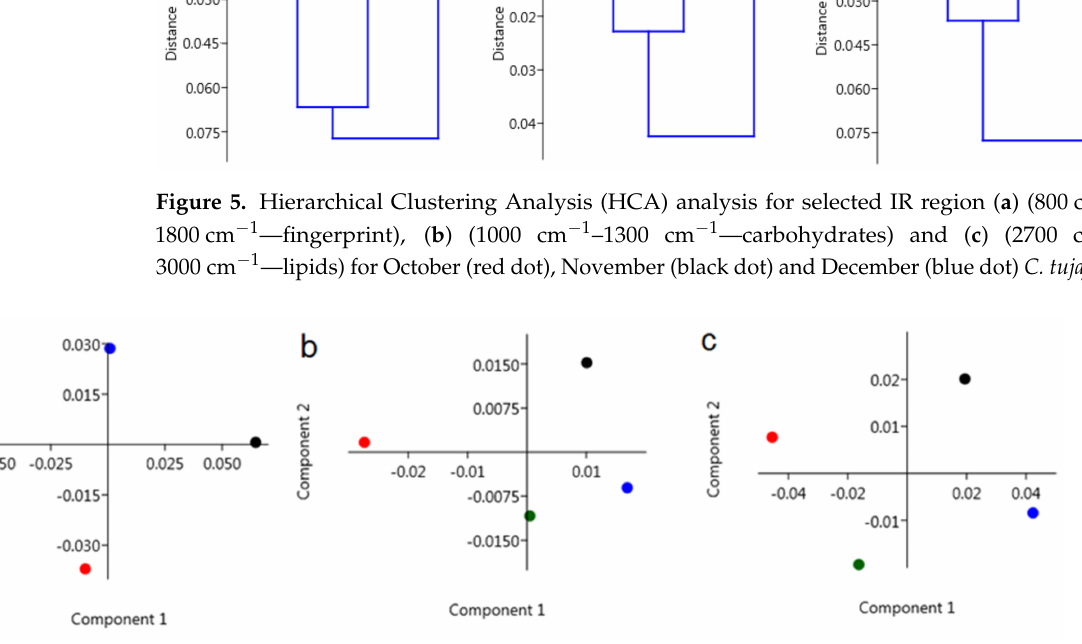
Figure 6. Principal Component Analysis (PCA) analysis for selected IR region ( a ) (800 cm − 1 –1800 cm − 1 —fingerprint), ( b ) (1000 cm − 1 –1300 cm − 1 —carbohydrates) and ( c ) (2700 cm − 1 –3000 cm − 1 —lipids) of summer (green dot) and winter months: October (red dot), November (black dot), December (blue dot) and of C. tujafilina